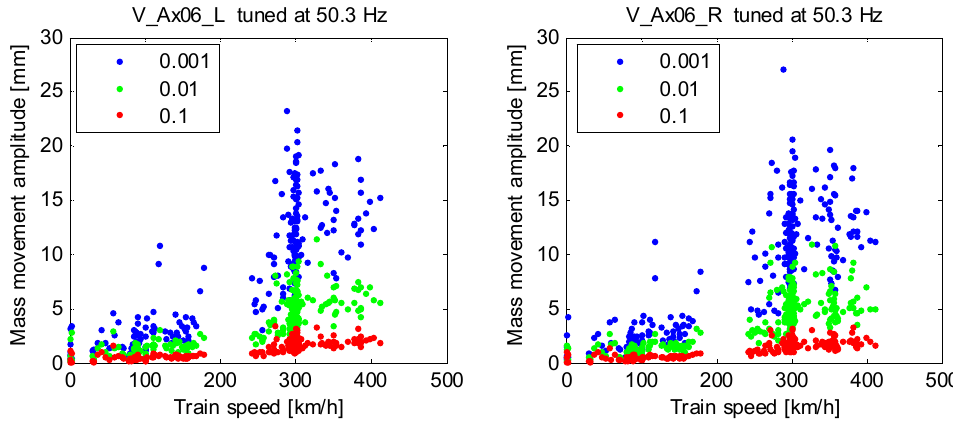
Figure 11. The estimated power generation from the vertical vibration of the axles when the total is 0.001, 0.01 or 0.1; the mass is 0.1 kg; and the natural frequency is 50.3 Hz (at the damping ratio  (cid:3021) vertical direction of each left and right side of the number 6 axle: V_Ax06_L and V_Ax06_R).